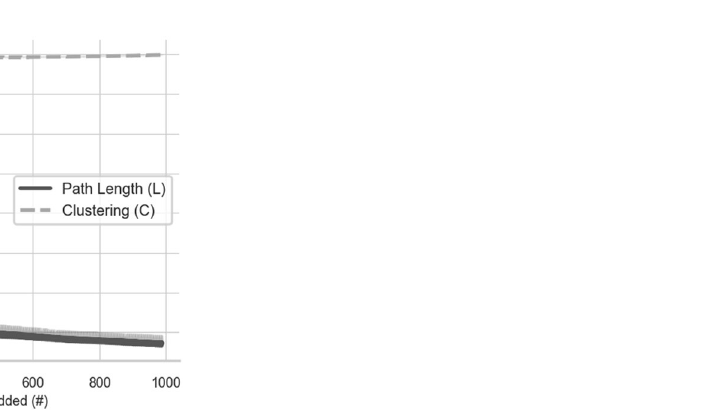
Figure 3. Transition from G1 to G2: clustering coefficient and average path